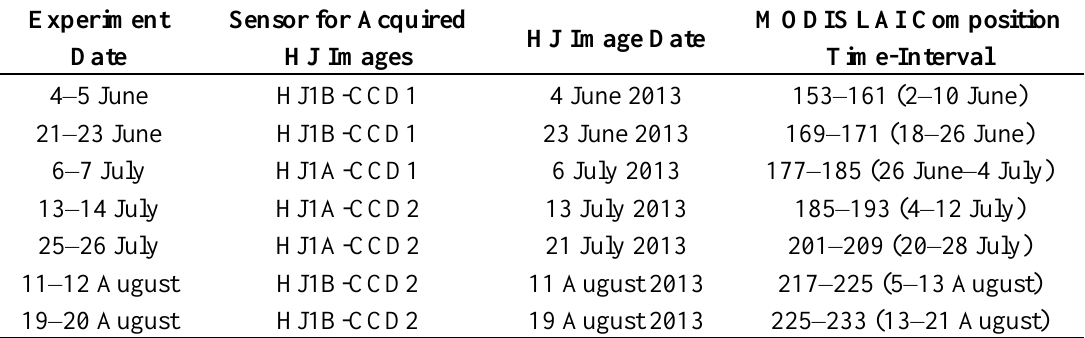
Table 1. Acquired remote sensing